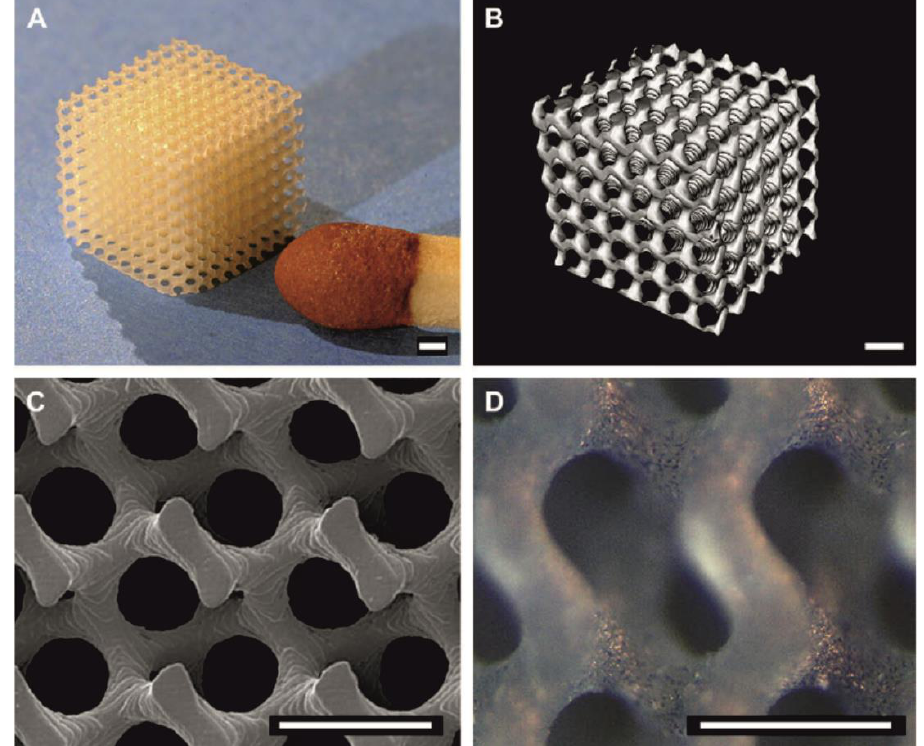
Figure 9. Images of PDLLA network scaffolds with a gyroid architecture prepared by stereolithography: ( A ) photograph, ( B ) microcomputed tomography (µCT) visualization and ( C ) SEM image. In ( D ) a light microscopy image is shown for a scaffold seeded with mouse pre-osteoblasts after 1 d of culturing. Scale bars represent 500 µm [57]. (With permission from Elsevier, 2009). Photolithography was also applied for the network synthesized by a different approach [107].